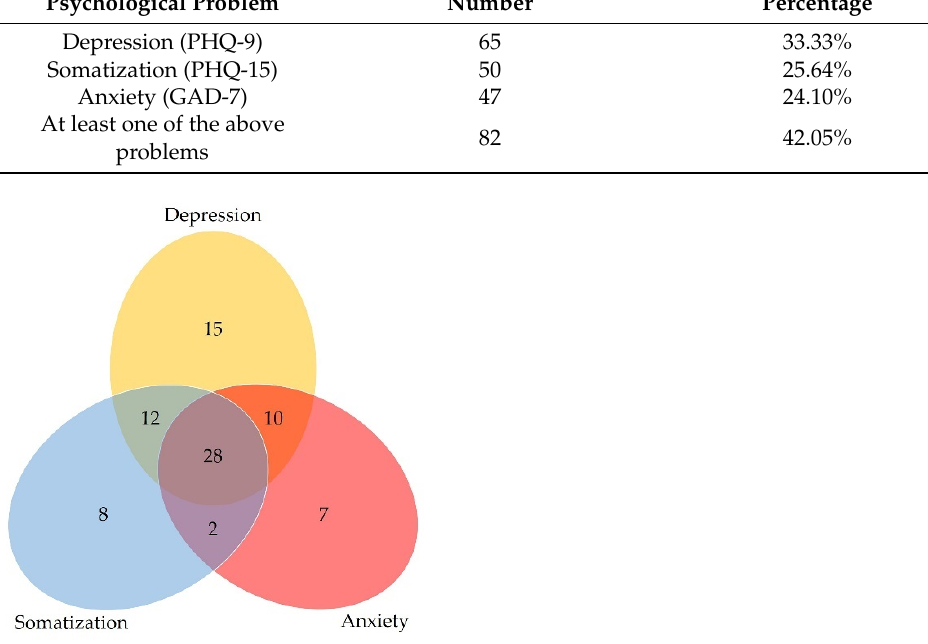
Figure 2. Venn diagram of the numbers of participants with psychological problems.